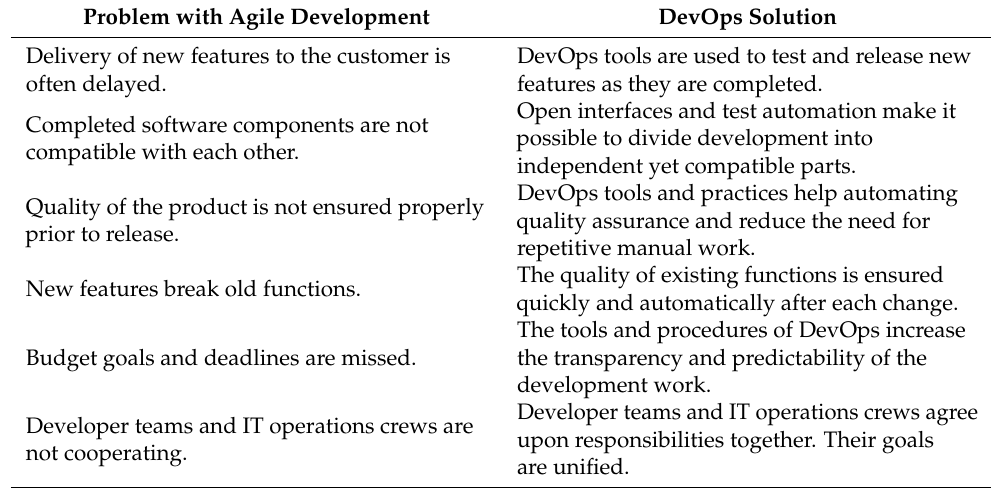
Table 1. Problems with Agile development and DevOps solution (adapted from